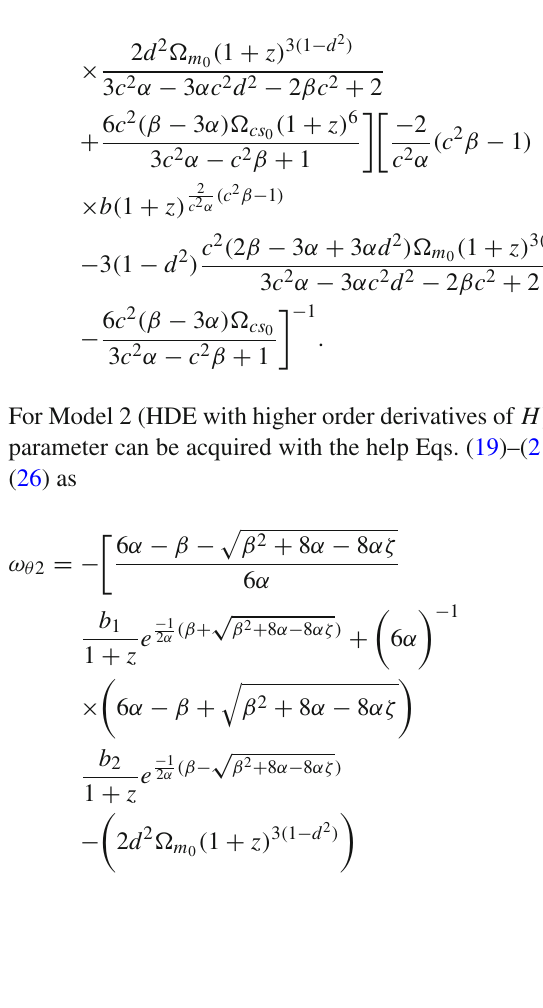
Fig. 2 Plots of growth index γ 1 ,γ 2 and γ 3 against